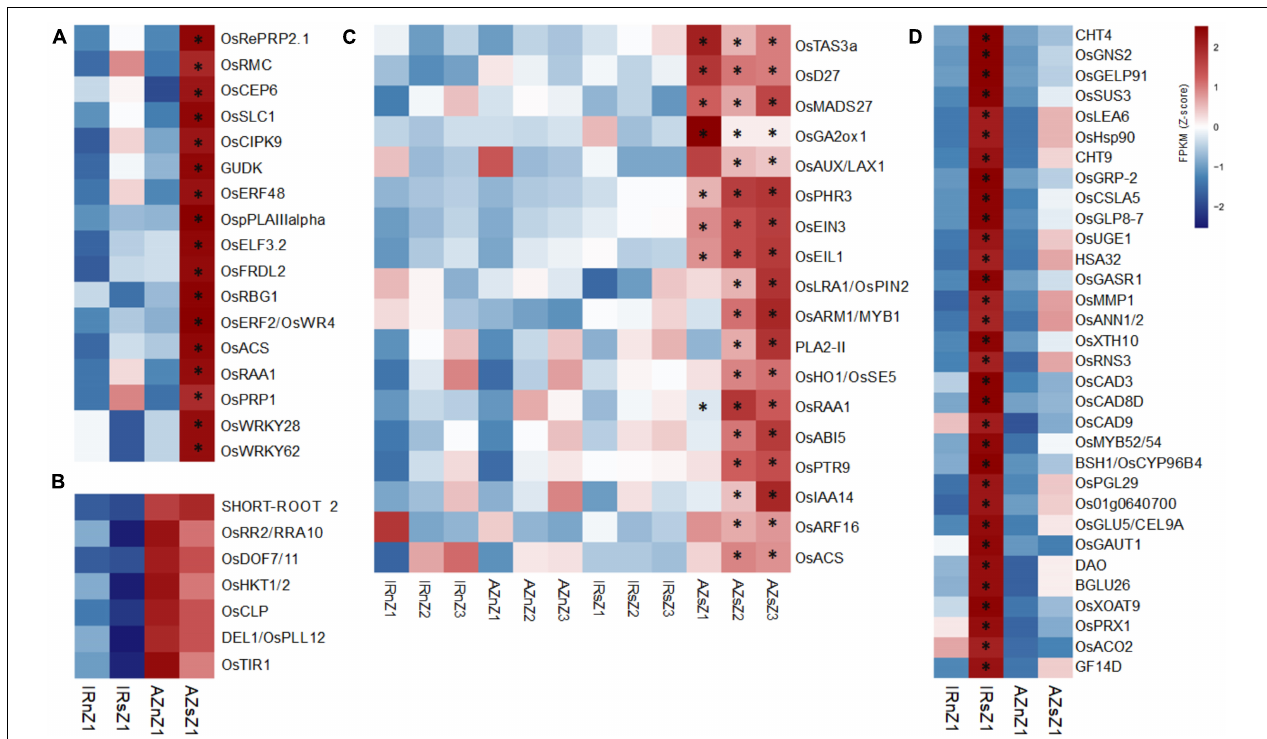
FIGURE 6 | The expression pattern of DEGs involved in root elongation, LR expansion and meristematic cell wall thickening across two contrasting genotypes under water stress. (A) Heatmap showing the expression patterns of genes affecting root length and significantly upregulated in Z1 of Azucena roots under stress conditions. The asterisks indicate significant interactions between genotypes and conditions ( p -value cut-off ≤ 0.05) analyzed by a two-way ANOVA test. (B) Genes affecting root length were expressed at much higher levels ( p -value cut-off of ≤ 0.05, analyzed by t -tests between genotypes in both conditions) in Z1 of Azucena roots under both conditions compared to IR64. (C) Heatmap showing the expression pattern of genes involved in lateral root formation, growth and development, induced and upregulated in response to stress only in Azucena root zones. The asterisks indicate significant interactions between genotypes and conditions ( p -value cut-off ≤ 0.05) analyzed by two-way ANOVA test. (D) Heatmap showing the expression pattern of genes involved in cell wall biogenesis and modification induced and upregulated in Z1 of IR64 roots under stress. The asterisks indicate significant interactions between genotypes and conditions ( p -value cut-off ≤ 0.05) analyzed by two-way ANOVA test. IRnZ1, root Z1 of IR64 under normal condition; IRnZ2, root Z2 of IR64 under normal condition; IRnZ3, root Z3 of IR64 under normal condition; IRsZ1, root Z1 of IR64 under stress condition; IRsZ2, root Z2 of IR64 under stress condition; IRsZ3, root Z3 of IR64 under stress condition; AZnZ1, root Z1 of Azucena under normal condition; AZnZ2, root Z2 of Azucena under normal condition; AZnZ3, root Z3 of Azucena under normal condition; AZsZ1, root Z1 of Azucena under stress condition; AZsZ2, root Z2 of Azucena under stress condition; AZsZ3, root Z3 of Azucena under stress